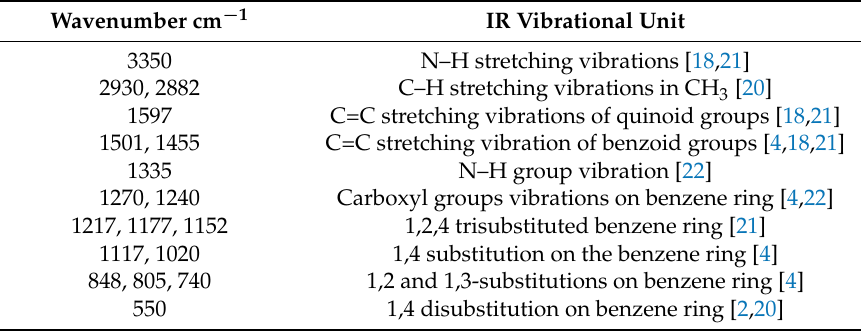
Table 4. IR spectral bands assignments identified in poly( o -anisidine) Figure 10. XRD diffraction patterns of the PANI 8 sample.